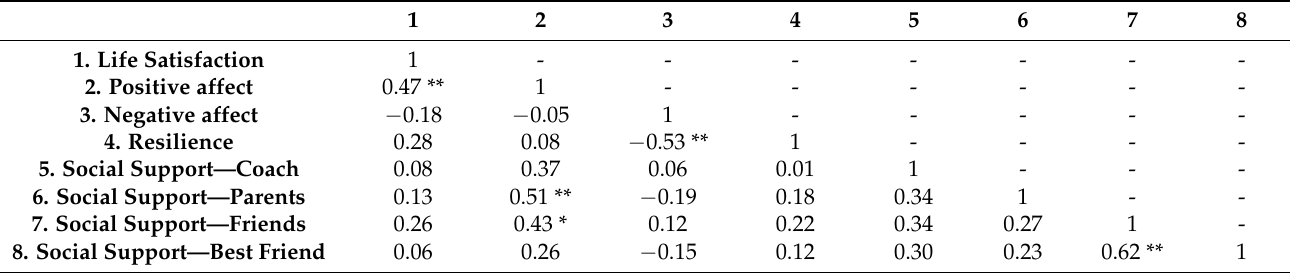
Table 3. Bivariate correlations between